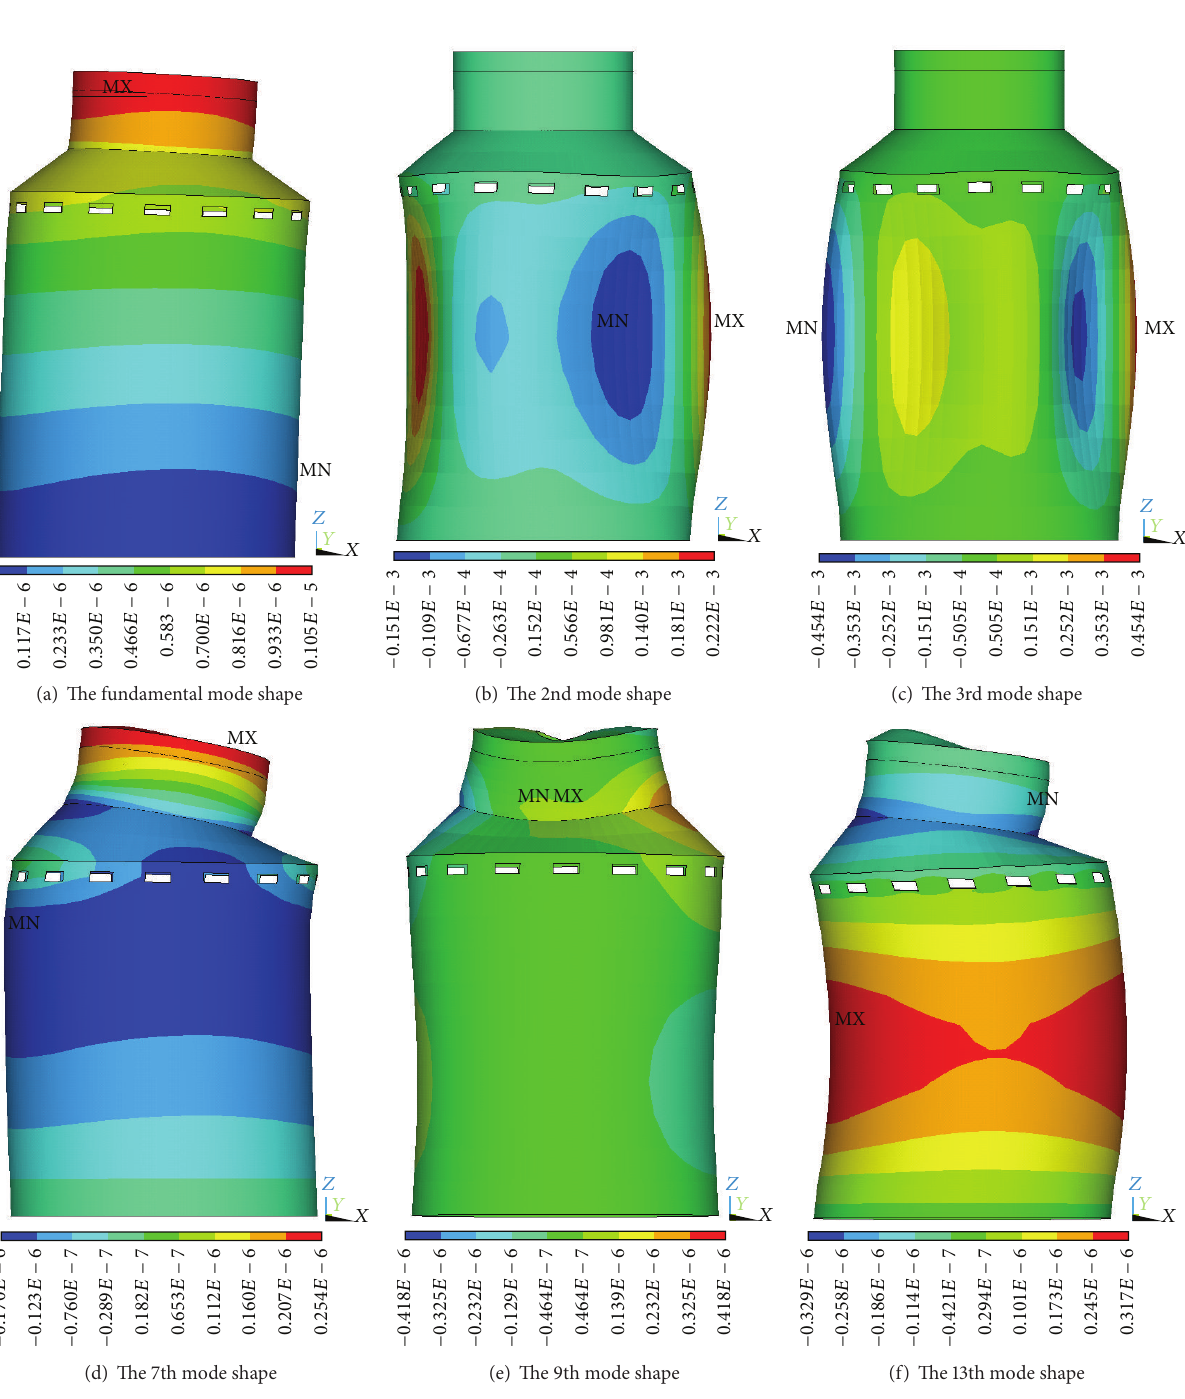
Figure 4: The mode shape of shield